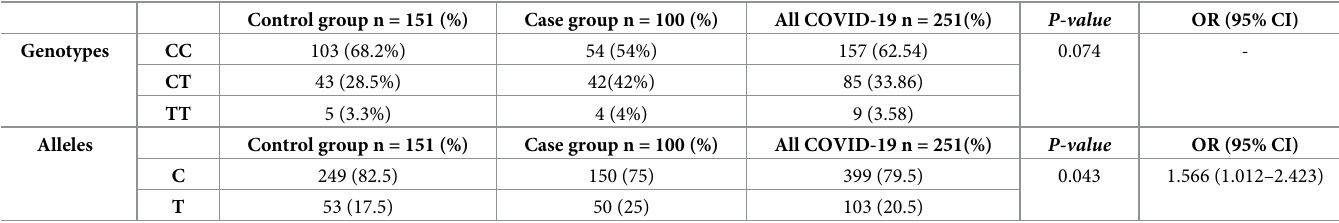
Statistical analysis between the association of the C and T alleles with the severity of symp- toms showed a statistically significant difference ( P-value = 0.043, OR = 1.566 (1.012–2.423). The frequency of the C allele decreased from 82.5% in the control group to 75% in the case group. The frequency of the minor T allele increased from 17.5% in the control group to 25% Table 2. Genotypes and alleles frequency of both control and case groups. P-values, odds ratio (OR) and 95% confidence intervals (95% CI). Control group n = 151 (%) Case group n = 100 (%) All COVID-19 n =